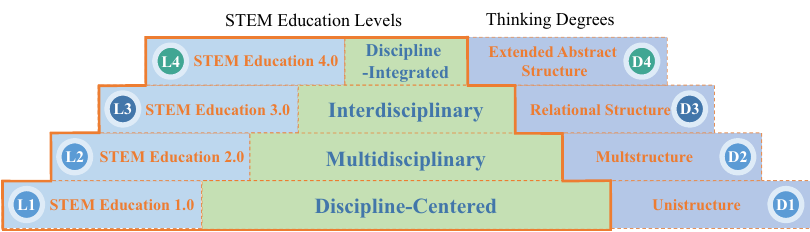
Fig. 2 Four levels of STEM education and their corresponding thinking degrees. STEM education 1.0 to 4.0 correspond to four levels of integration: Disciplinary, Multi-disciplinary, Interdisciplinary, Discipline-Integrated. The thinking degrees corresponding to each type of integration are unistructural, multi-structural, relational and extended abstract